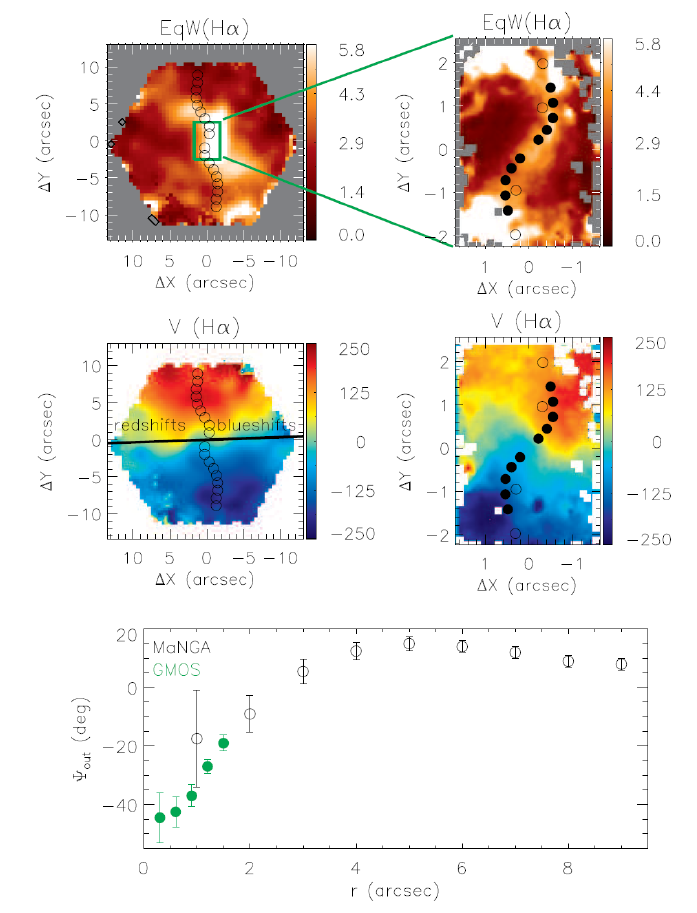
Figure 8. Outflow orientation of the prototype Red Geyser Akira (Figure 4 in [116]). SDSS MaNGA (left panels) and Gemini-GMOS IFS (right panels) display different scales of the galaxy (Gemini FoV represented by the red rectangle in the top left panel), with top and middle panels showing the H α equivalent width and velocity maps, respectively. Circles represent the orientation of outflowing gas, after interpreting that these regions cannot be reproduced by disk-like rotation, where open and closed circles are using MaNGA and GMOS data, respectively. Redshifted and blueshifted velocities obtained from the stellar kinematics are identified, along the line of the nodes measured in the stellar velocity field. The bottom panel displays the outflow orientation relation with distance to the nucleus. The variation in outflow orientation is interpreted as precessing winds due to the orientation of the accretion disk in relation to the SMBH